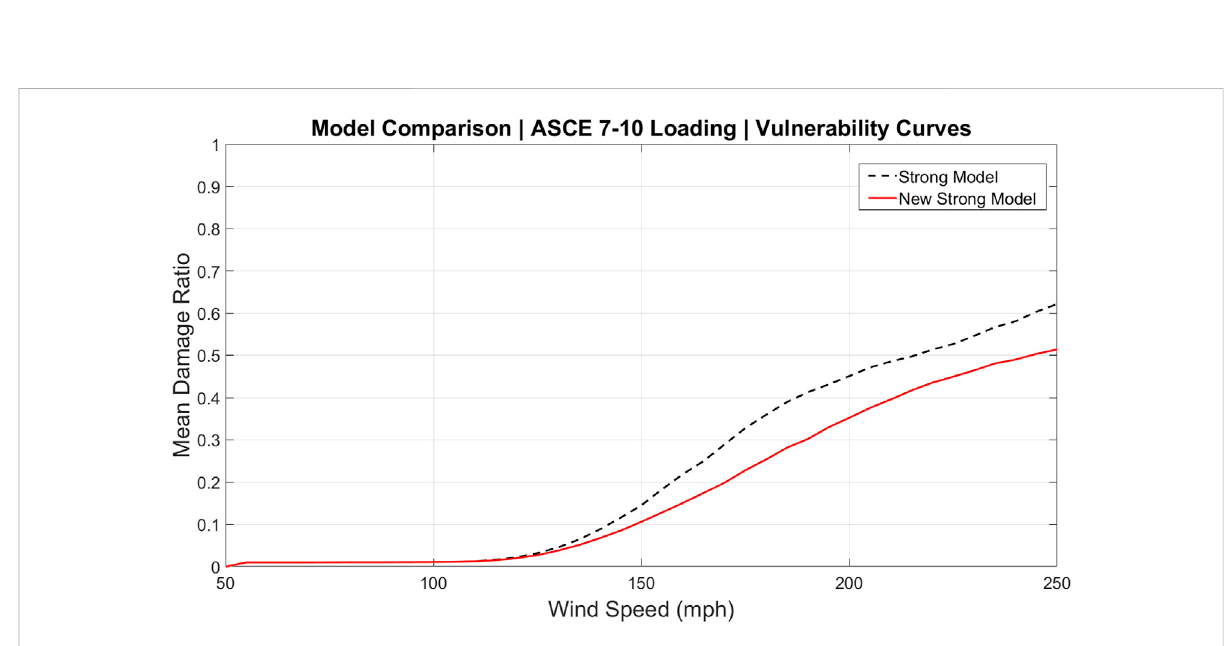
FIGURE 7 Vulnerability curves of the strong and new strong models under ASCE 7 – 10